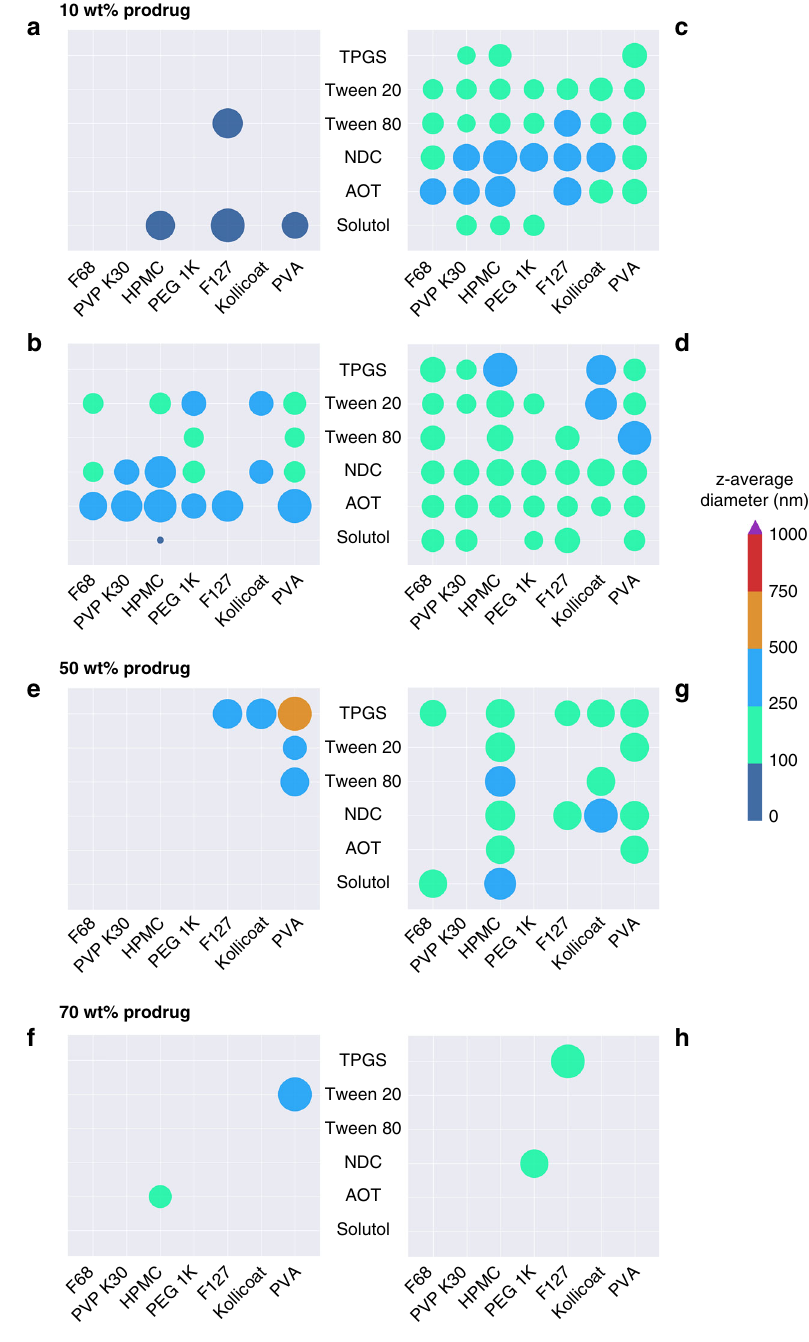
Fig. 4 Overview of hits mapped onto binary excipient combinations. a – d Hits identi fi ed for prodrugs 2 , 4 , 6 , and 8 respectively at 10 wt% drug loading relative to excipients, e , g impact on number of hits and z -average diameter after increased prodrug loading to 50 wt% for 4 and 8 respectively, and f , h impact on number of hits and z- average diameter after increased prodrug loading to 70 wt% for 4 and 8 respectively. Each colour represents a size range (as indicated by the legend) and circle diameter represents whether the z -average diameter value resides at the lower or higher end of the